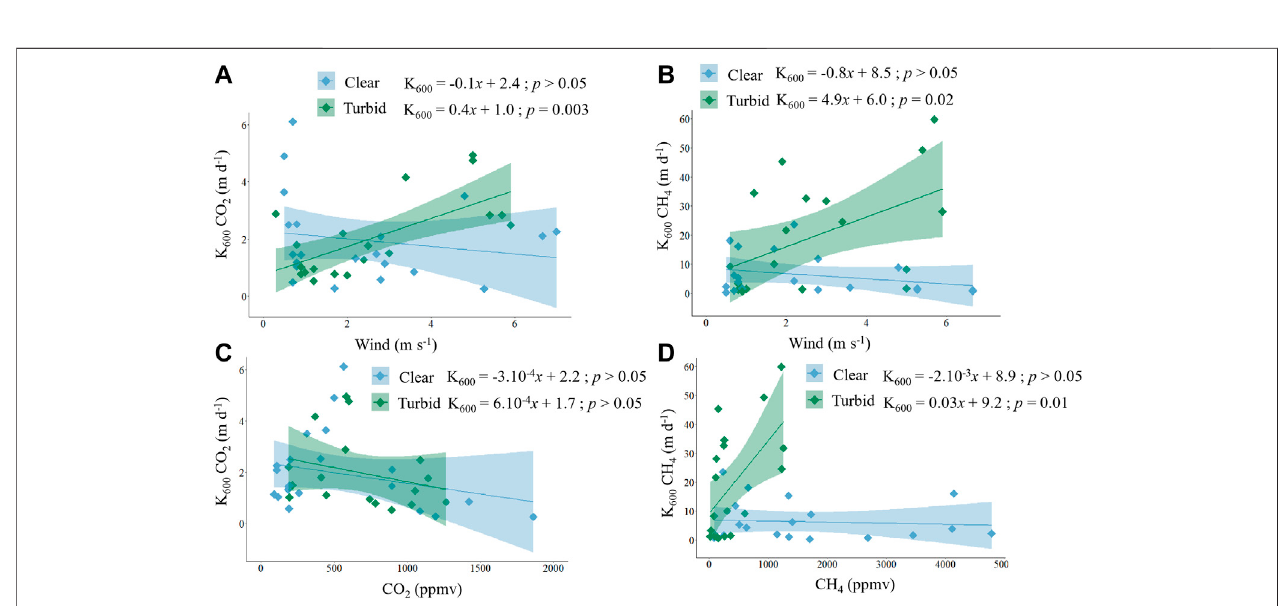
FIGURE 5 | Linear regressions between (A) k 600 CH 4 and wind, (B) k 600 CO 2 and wind, (C) k 600 CH 4 and p CH 4 , and (D) k 600 CO 2 and p CO 2 . Blue diamonds correspondtoclearvegetatedlakeswhilegreendiamondscorrespondtoturbidalgallakes.Theshadecorrespondstothestandarderroroftherespectivelinearmodels and p values correspond to the slope of the regression